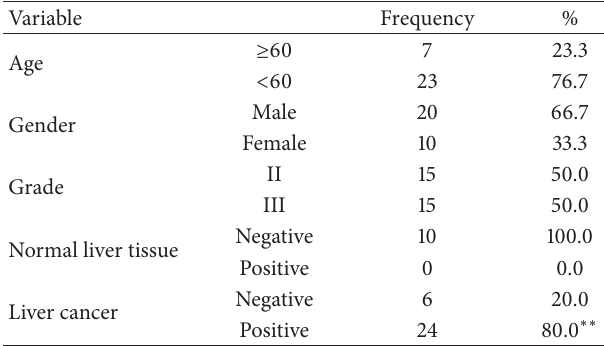
Table 2: Characteristics of patients and MDM2 expression in liver